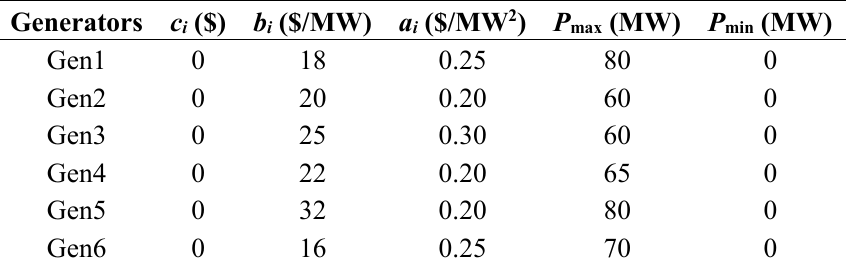
Table 1. Producers